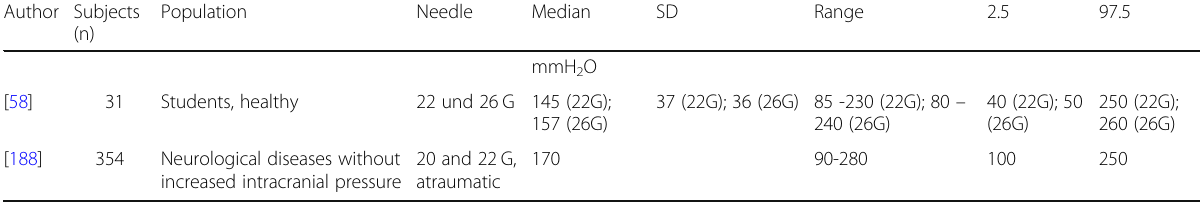
Table 22 CSF pressure is dependent on the caliber of the needle used for puncture Author Subjects (n)